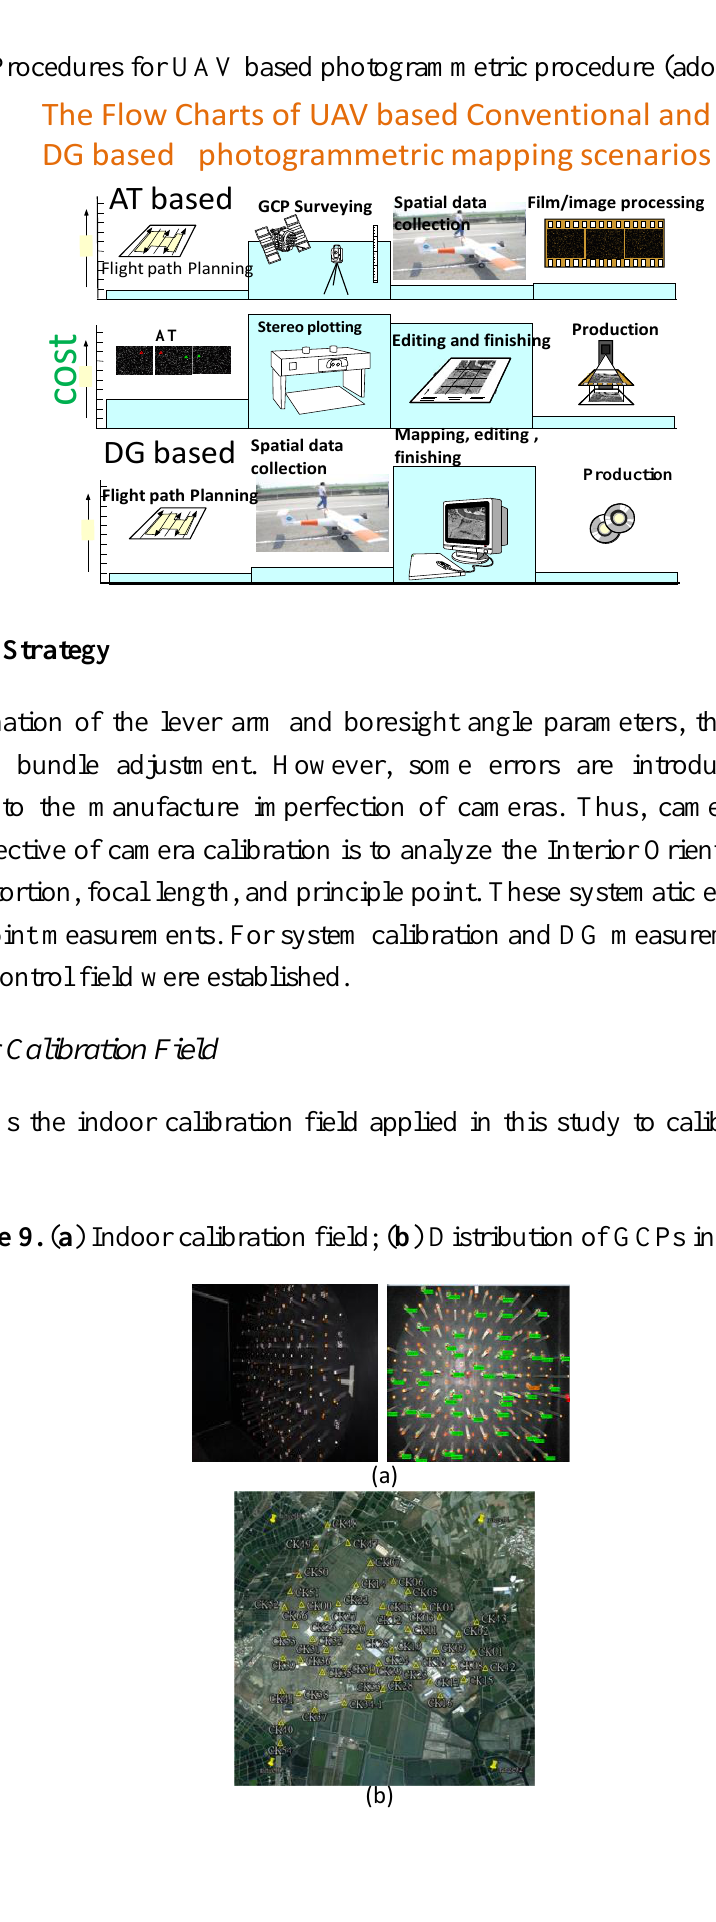
Figure 8. Procedures for UAV based photogrammetric procedure (adopted from [1]).